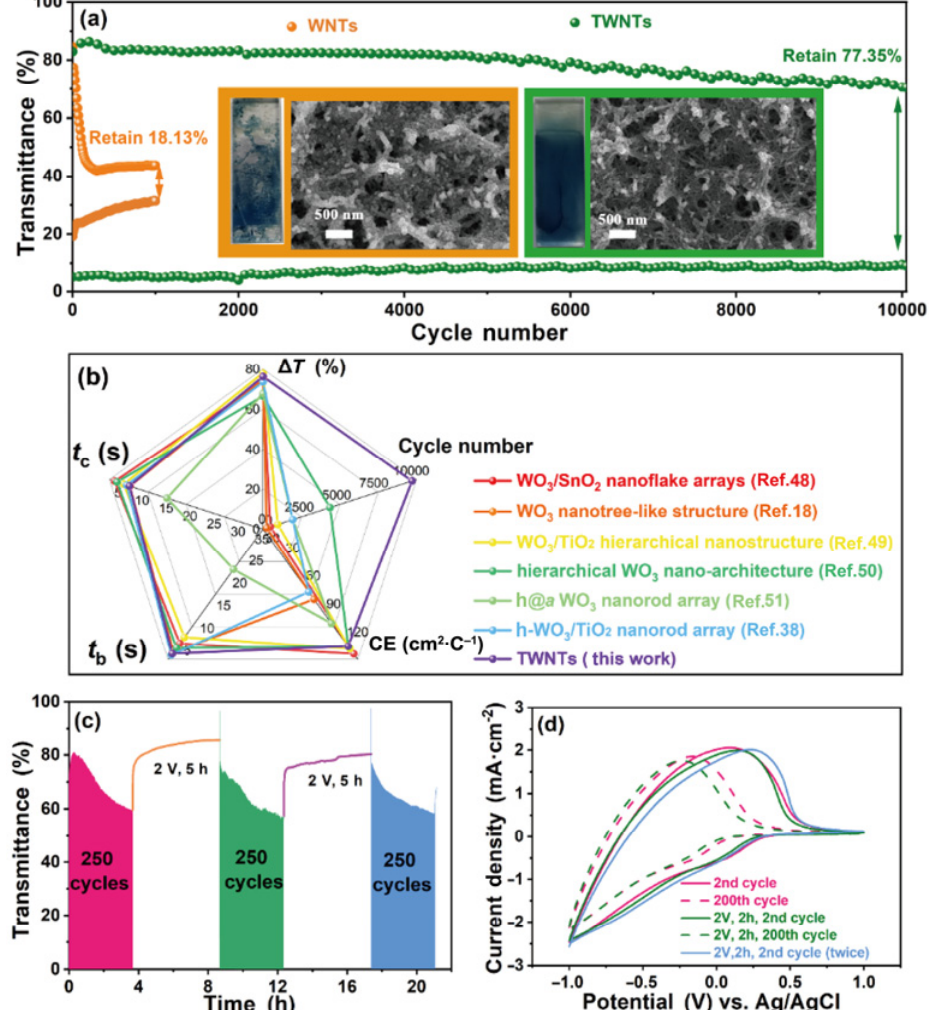
Fig. 6 Cycle stability and recoverable study of WNTs and TWNTs films. Transmittance modulation stability of WNTs and TWNTs films at 633 nm (a). Insets represent the optical and SEM images of WNTs (left) and TWNTs (right) films after cycles. Electrochromic performance comparison of TWNTs film with other WO 3 -based heterostructures (b). Trap induced degradation and potentiostatic de-trapping of transmittance modulation (c) and CV curves (d) of TWNTs